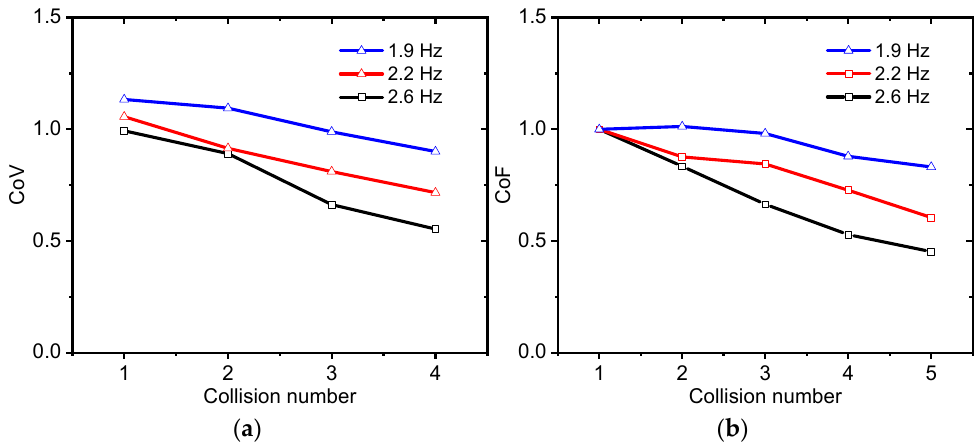
Figure 17. CoVs and CoFs regarding different contact frequencies. ( a ) CoV. ( b ) CoF.